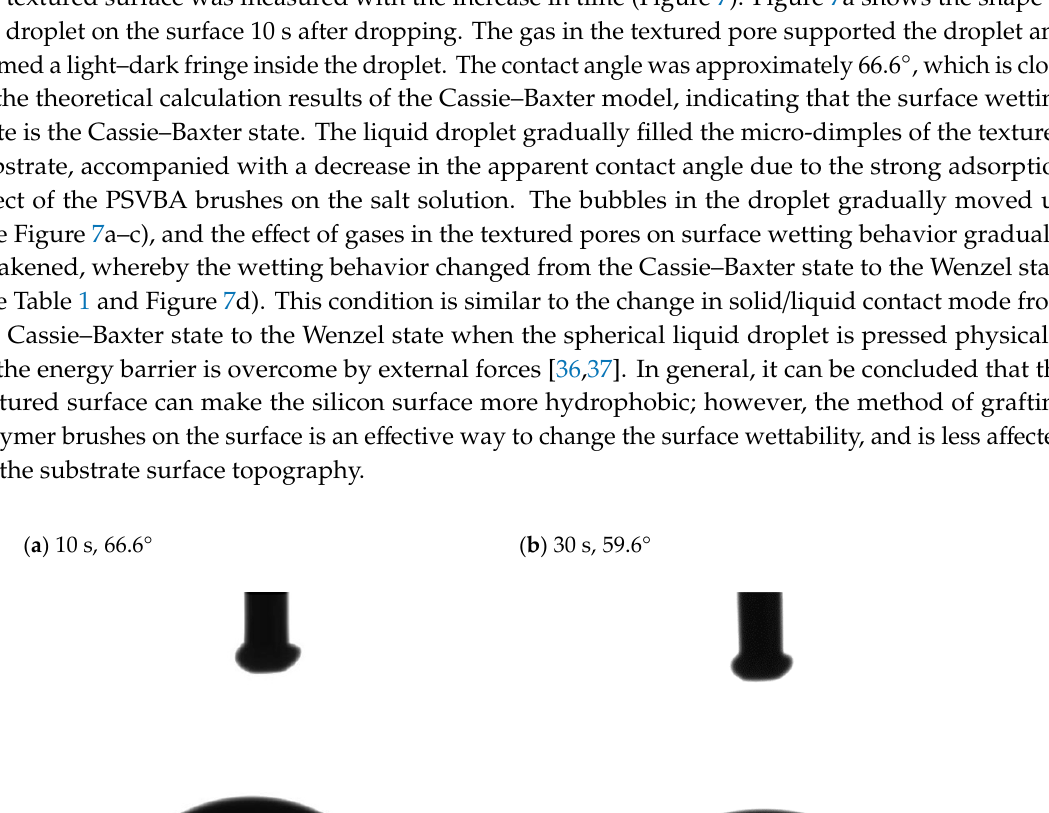
Figure 7. Static contact angle of PSVBA-grafted textured surface at different times ( a – c ), and its evolution with time increased ( d ) under saturated NaCl solution conditions. 3.3. Analysis of Friction Coefficient and Wear Resistance Figure 8 shows the average friction coefficients at the initial stable stage for different modifications. It can be seen that the friction coefficient of PSVBA brushes grafted on flat surfaces is less than 0.03, which is approximately 1/50 of the original surface. Meanwhile, the friction coefficient of the textured surface reached 0.964, which is approximately 32% lower than that of the flat surface. The surface texture anti-friction was widely confirmed by various reports [38]. This condition is attributed to surface micro-pits that can reduce the contact area and effectively improve the fluid- bearing capacity on the surface, thus reducing friction and wear under lubrication. In addition, grafting PSVBA brushes can immensely reduce the friction coefficient of the textured surface, and the friction reduction effect is higher compared with that on the flat silicon surface. Significant anti- friction effects of the grafted surface of polymer brushes were reported by a number of researchers [4,39]. Other studies showed that the excellent lubrication performance of PSVBA brushes is due to their ability to hydrate under high concentrations of salt solution (Figure 6). This condition results in a highly stretched conformation of polymer chains in the interface and the generation of an osmotic pressure repulsive force from polymer chains opposite to the applied load, which can effectively improve the load-carrying capacity of the surface and promote the formation of a thin fluid lubrication film, resulting in a low surface friction coefficient.